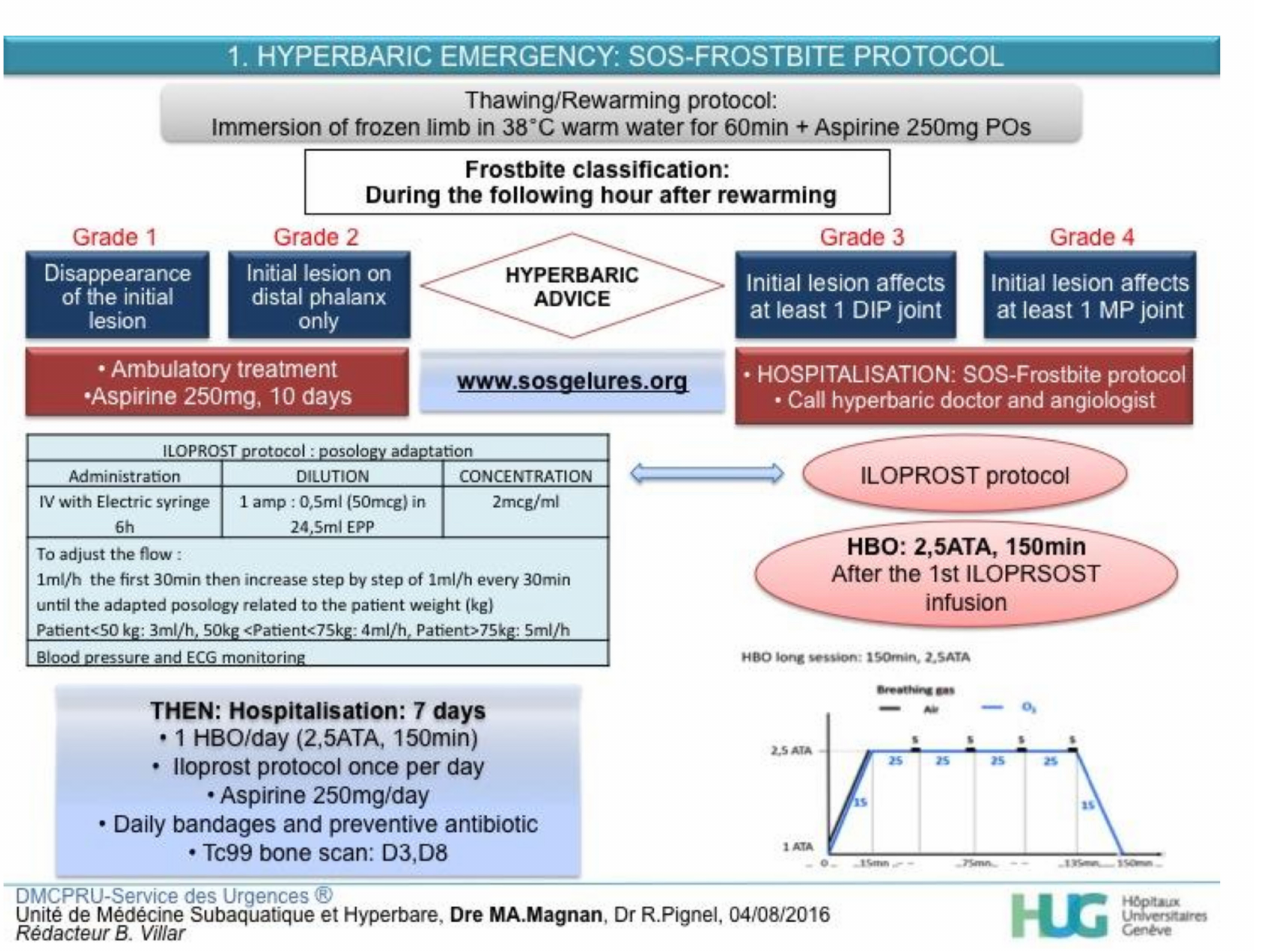
Figure A1. The SOS-Frostbite protocol during hospitalization at university hospitals of